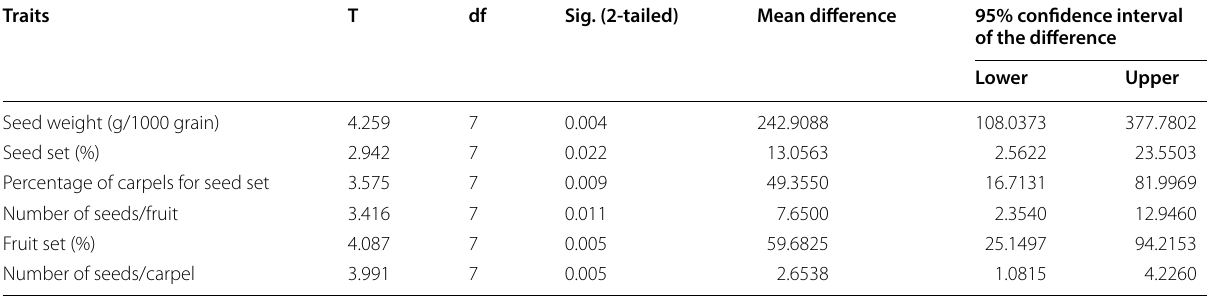
Table 1 One-sample t test in seed weight (g/1000 grain), seed set (%), percentage of carpels for seed set, number of seeds/fruit, fruit set (%) and number of seeds/carpel in P. decomposita